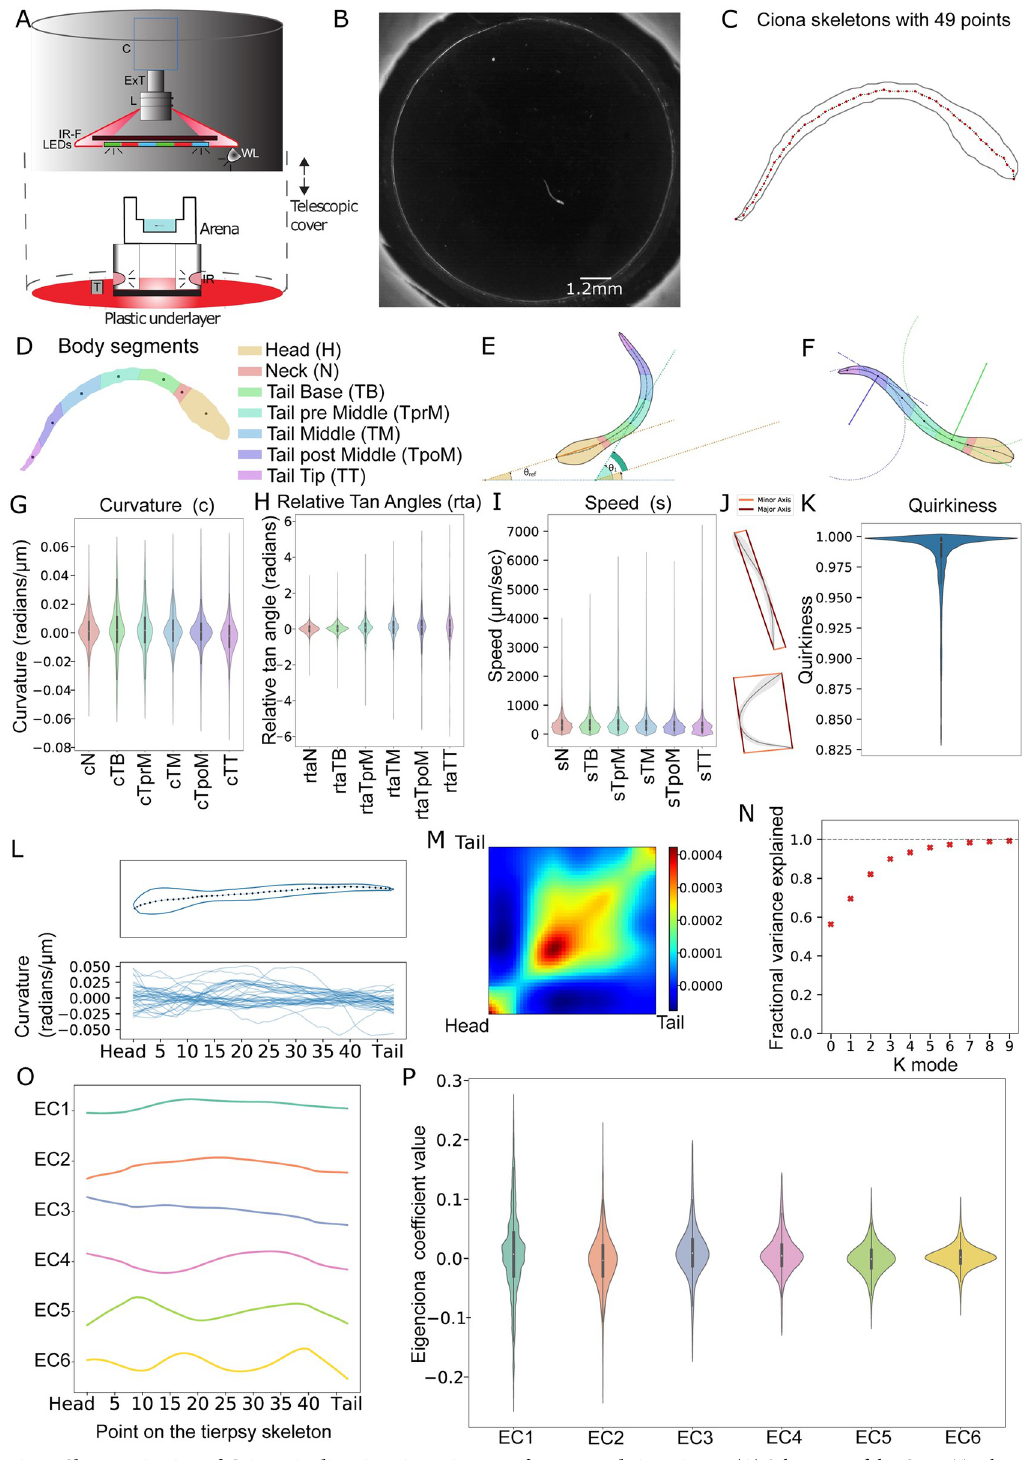
Fig 1. Characterization of C . intestinalis swimming using core features and eigencionas. (A) Schematic of the Ciona Tracker 2.0 video acquisition setup. Each setup was composed of a monochrome camera (C), connected to an extension tube (ExT) and a magnification lens (L). A holder piece housed an IR filter (IR-F), a set of LEDs and a white light source (WL). The arena was nested in a PLA ring that housed the infrared lights used for dark field illumination (IR). A plastic underlayer secures the PLA ring and a thermometer that reports temperature for each acquisition setup. A telescopic plastic cover shields the arena from